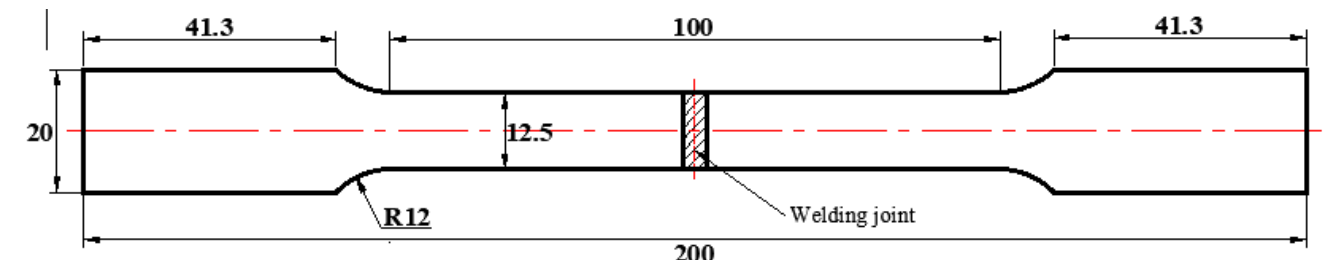
Figure 3. Dimensions of tensile samples.